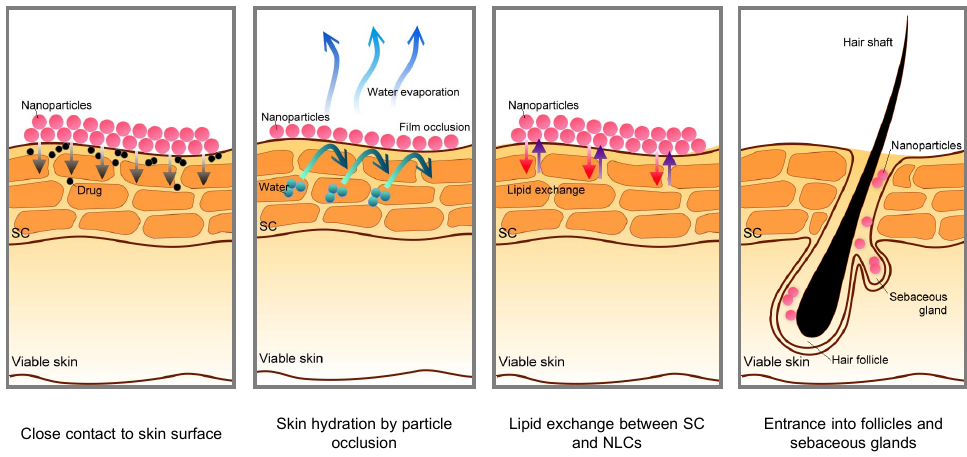
Figure 2. Schematic mechanisms for skin permeation of active components from nanoparticles [29].